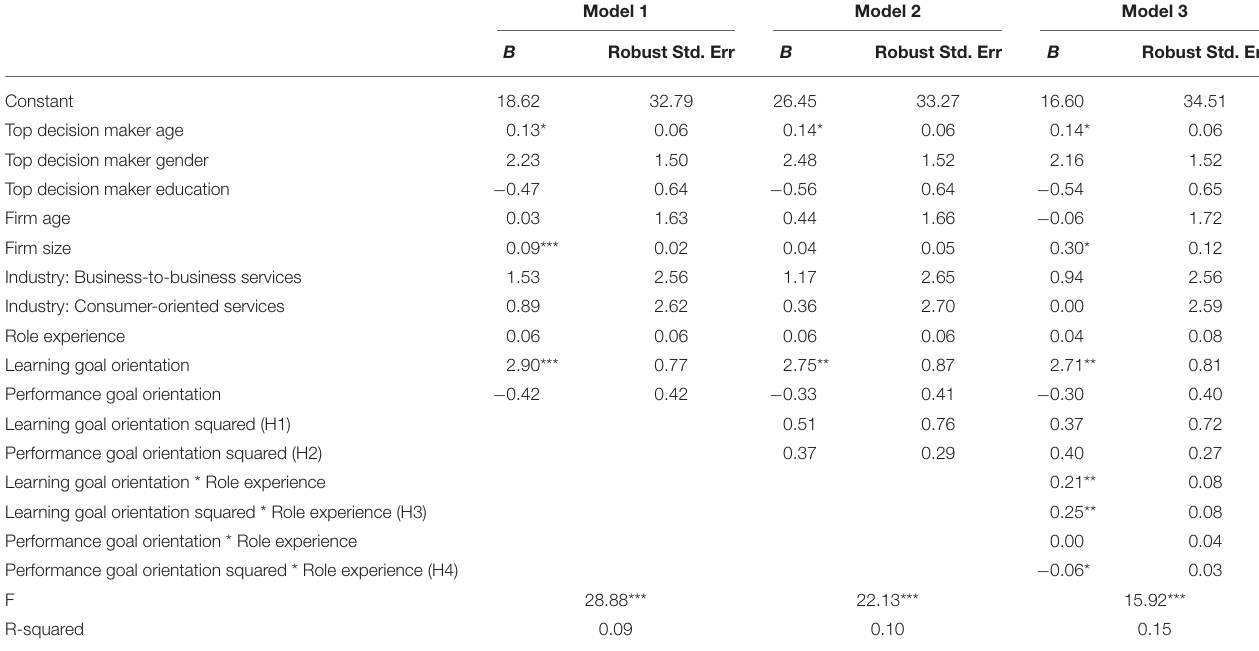
TABLE 4 | Hierarchical regression analysis, predicting firm ambidexterity.